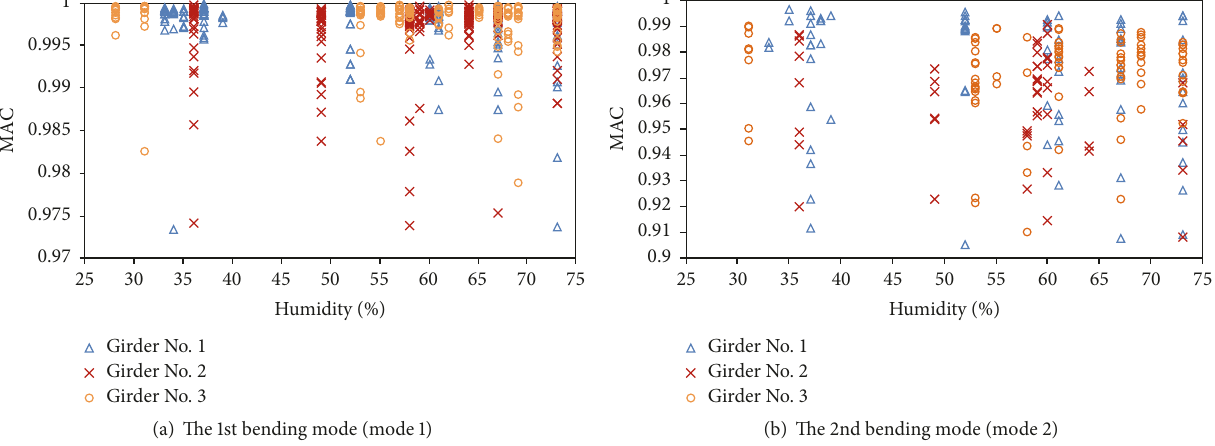
Girder No. 1 Girder No. 2